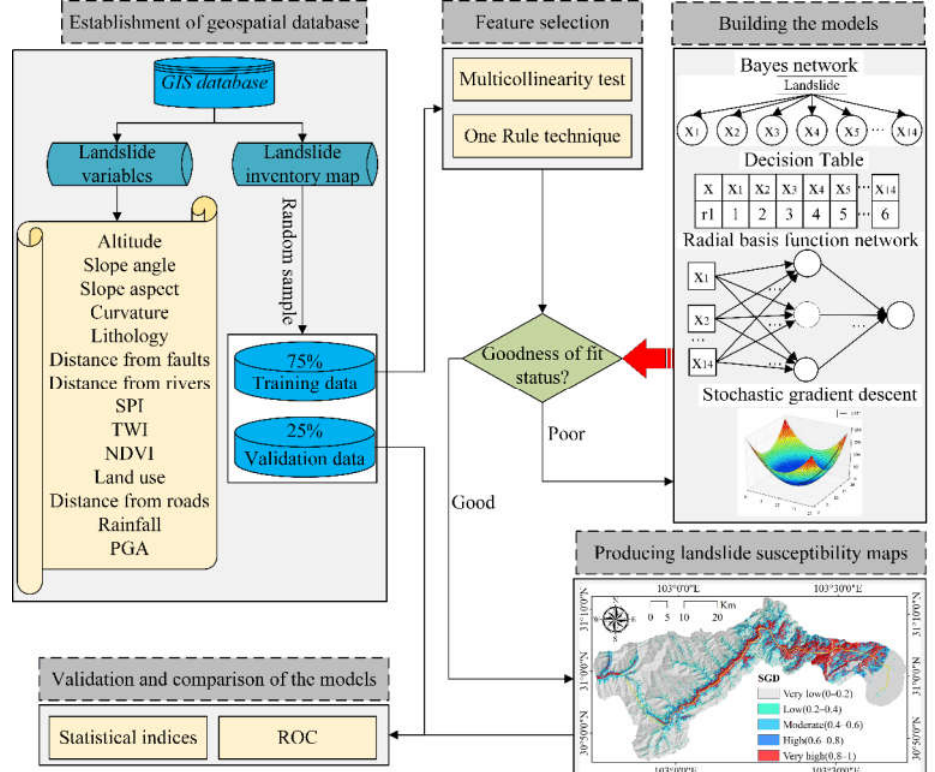
Figure 4. Flowchart of the proposed methodology.